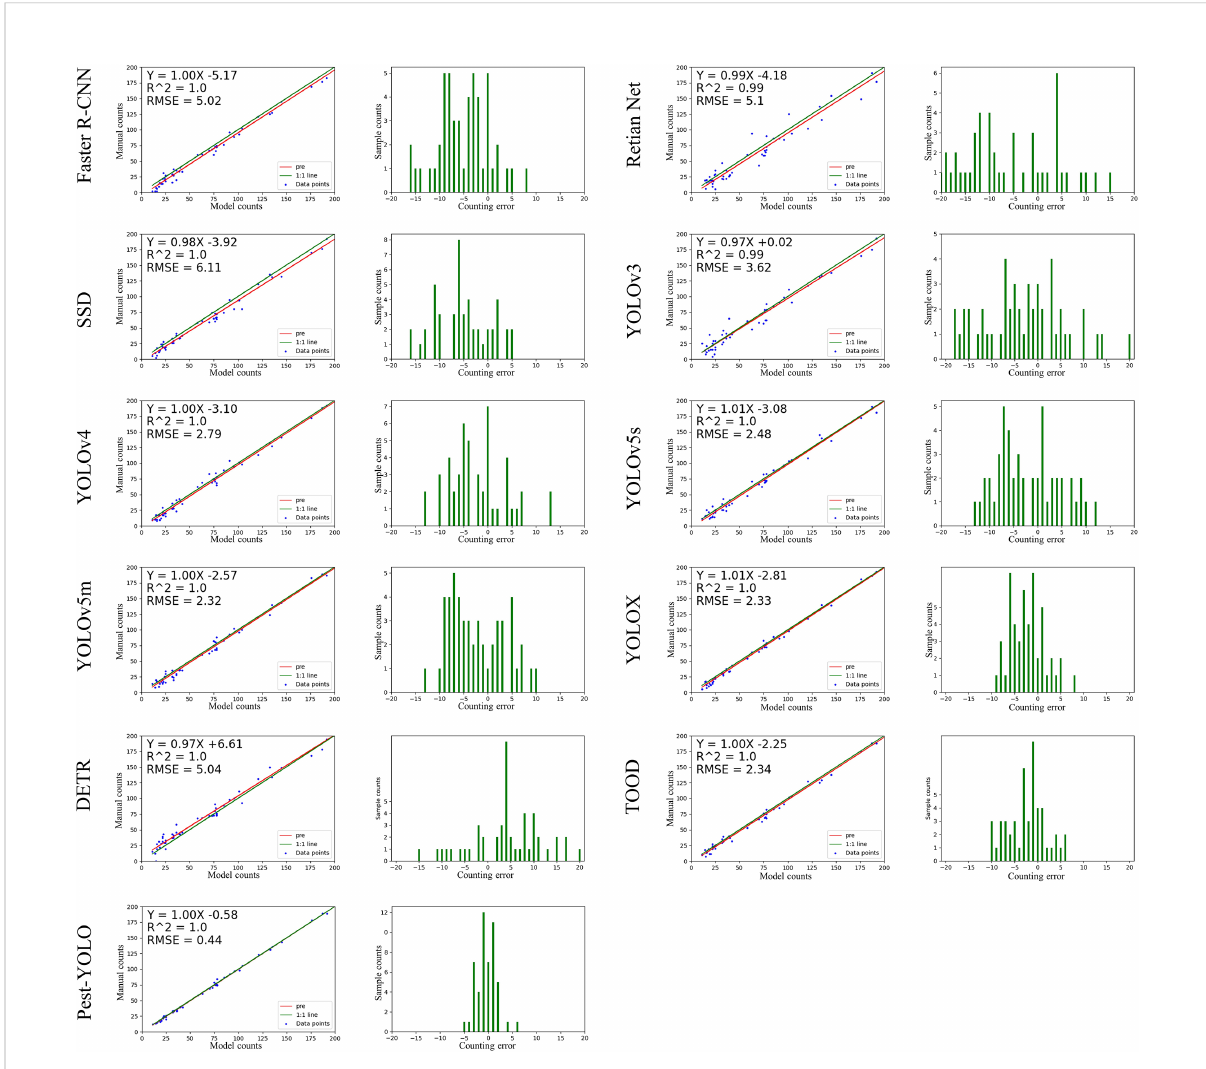
FIGURE 8 Plot of the counting test results of the models. The left fi gure is a plot of the linear regression results between the imaging-derived and manual counts; the red line represents the regression curve predicted by the model, and the green line represents the true number of pests. The right fi gure is a histogram of the counting error, where the x-axis represents the counting error of the model, and the y-axis represents the number of